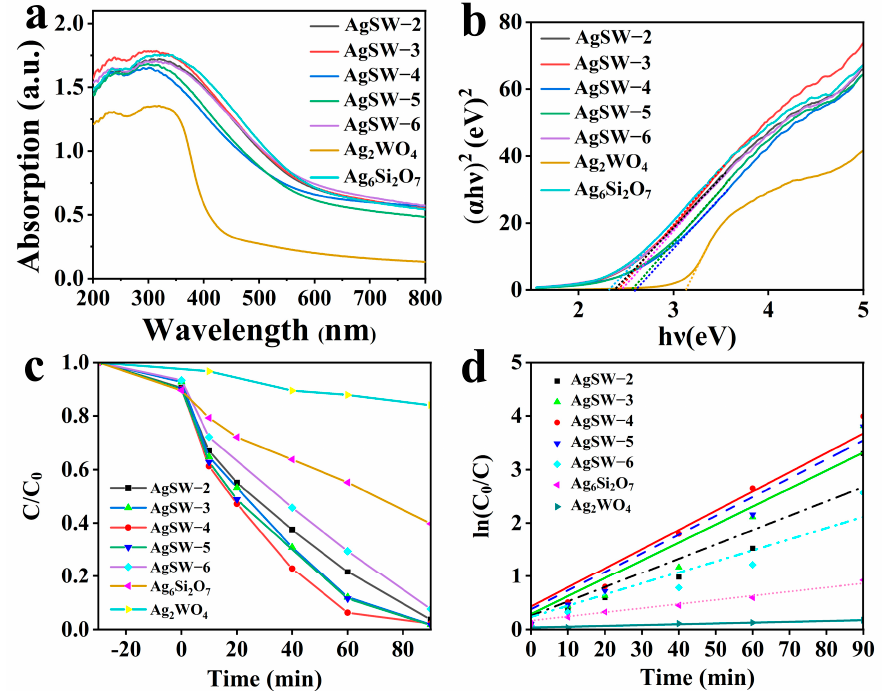
Figure 5. ( a ) UV–vis DRS of Ag 2 WO 4 , Ag 6 Si 2 O 7 , and Ag 6 Si 2 O 7 /Ag 2 WO 4 composites. ( b ) Plots of ( α h ν ) 2 versus (h ν ) for samples. ( c ) Rate of RhB photocatalytic degradation with different as-prepared photocatalysts. ( d ) Plots of the rate constants k for RhB degradation using the as-prepared samples. Table 2. The bandgap of the